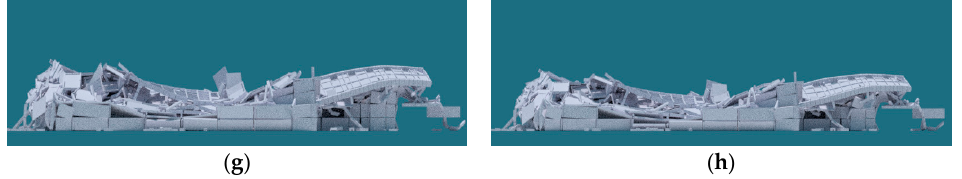
Figure 13. Collapse process of the library building: ( a ) t = 2.01 s; ( b ) t = 3.01 s; ( c ) t = 3.64 s; ( d ) t = 4.26 s; ( e ) t = 5.51 s; ( f ) t = 6.97 s; ( g ) t = 14.26 s; ( h ) t = 18.43 s.